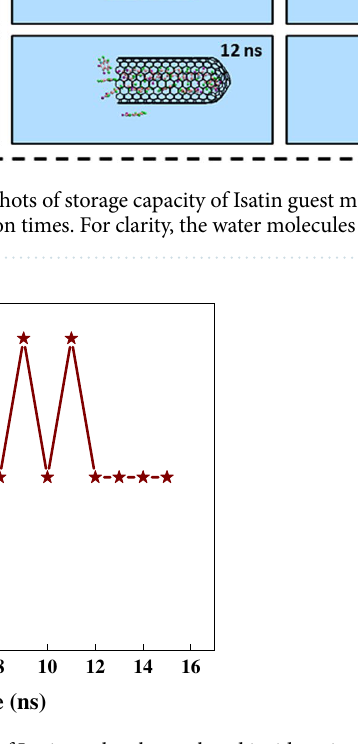
Figure 8. A potential number of Isatin molecules enclosed inside a single capped SWCNT (10,10) host carrier as a function of simulation